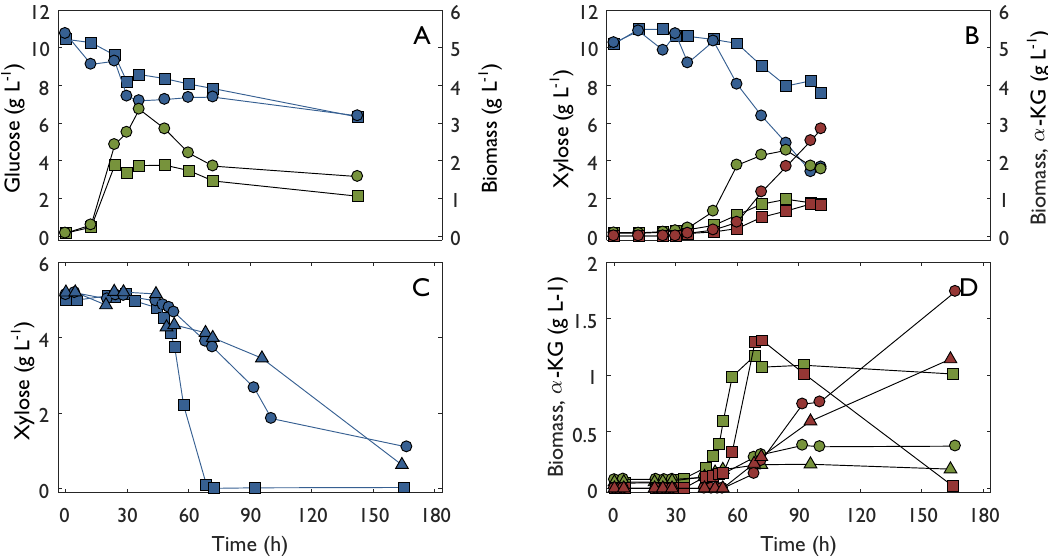
Figure 4. Metabolite profile from bioreactor experiments with C. crescentus in three conditions. The substrate was 10 g L − 1 of glucose ( A ), 10 g L − 1 of xylose ( B ) or 5 g L − 1 of xylose ( C , D ). Substrate is marked with blue symbols, biomass with green symbols and α -ketoglutarate with red symbols. Circles, squares and triangle are used to distinguish between different replicates of the